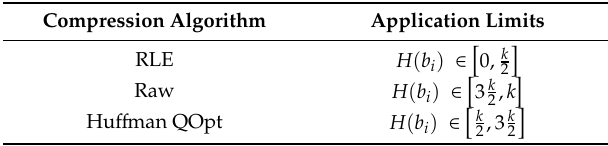
Table 7. Application limits for each compression